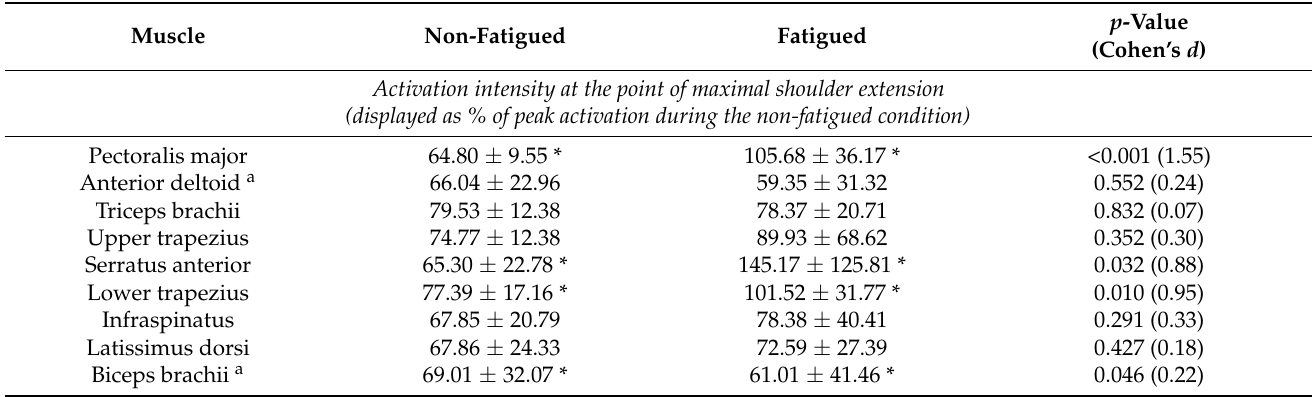
Figure 2 . Mean peak sEMG amplitudes for each muscle during the bar dip in non ‐ fatigued (black) Figure 2. Mean peak sEMG amplitudes for each muscle during the bar dip in non-fatigued (black) and fatigued (white) conditions. * indicates a significantly greater muscle activation intensity in the fatigued condition, § indicates a small effect size ( d > 0.2), † indicates medium effect size ( d > 0.8), ‡ indicates a very large effect size ( d > 1.2). A Wilcoxon signed-rank test was used for the upper trapezius, serratus anterior, and biceps brachii. Table 2. Maximal (mean ± SD) Activation intensities at the point of maximal shoulder